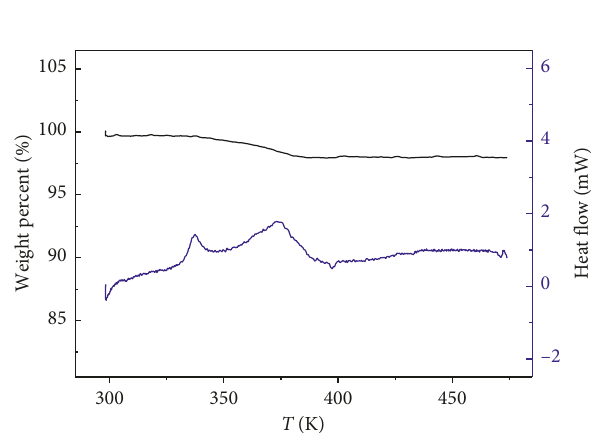
Figure 1: The TG–DSC curve of the recrystallized NaAsO Table 2: Comparison of densities of pure water at different temperatures between the experimental and the literature data.